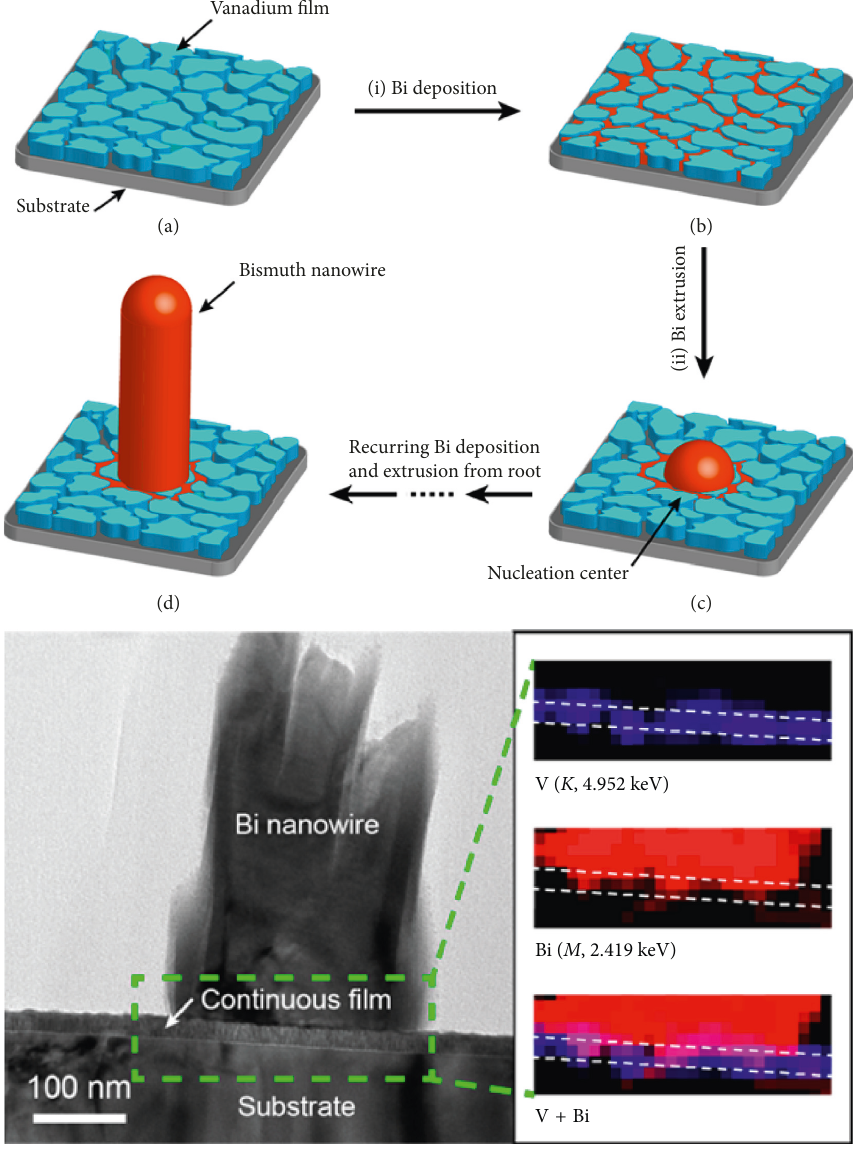
Figure 7: (a–d) Simplified representation of the growth of a Bi nanowire on a vanadium film following the root-growth mode. (e) TEM image of a Bi nanowire on the substrate. The energy dispersive X-ray (EDX) mapping of the distribution of the different species is also shown [39]. Reprinted with permission from the American Chemical